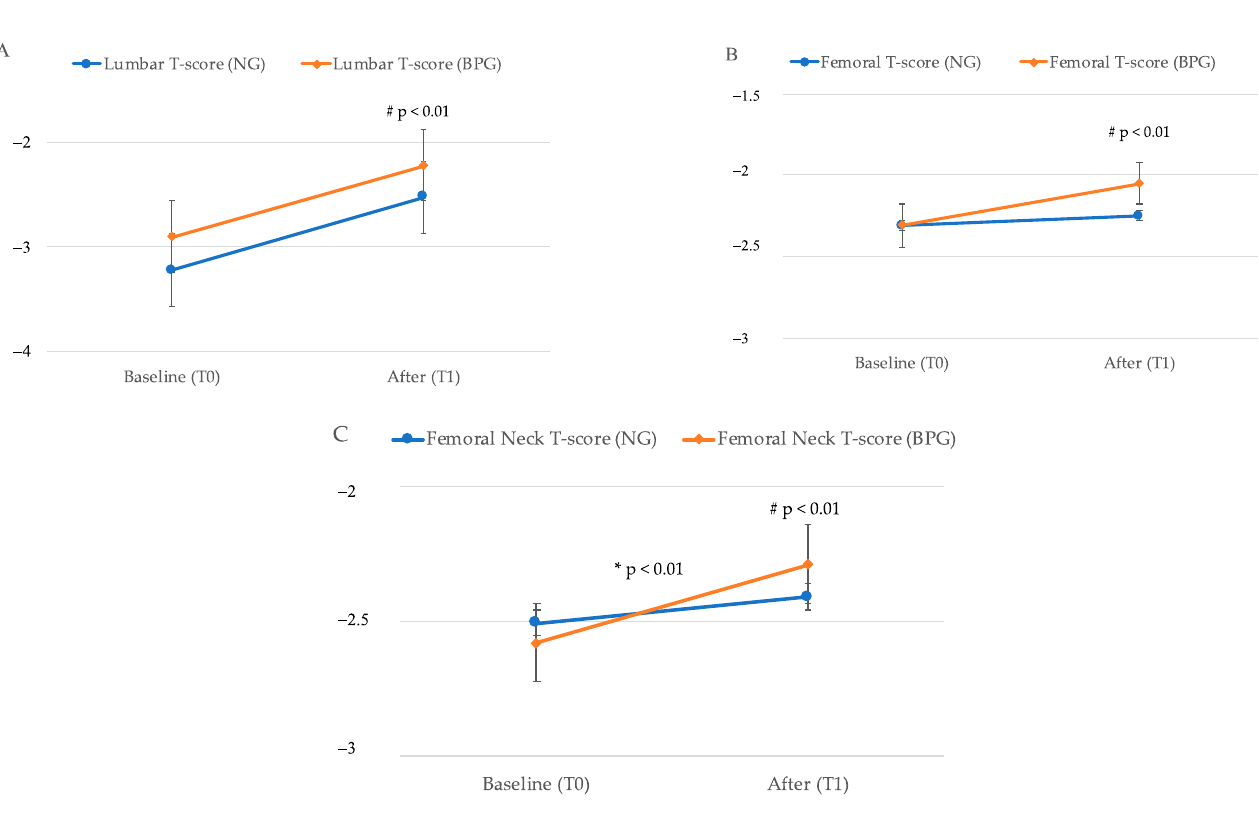
Figure 2. Comparison between BMD T-score (mean value, standard error) in NG (blue line) and BPG (red line) group at baseline T0 and after T1 denosumab. ( A ) Lumbar spine T-score measurement; ( B ) Femoral T-score measurement; ( C ), Femoral Neck T-score measurement. * Represents statistical significant difference effect for time ( p ≤ 0.05), while # indicates statistical significant difference effect for time therapy ( p ≤ 0.05) as more extensively reported in table4.